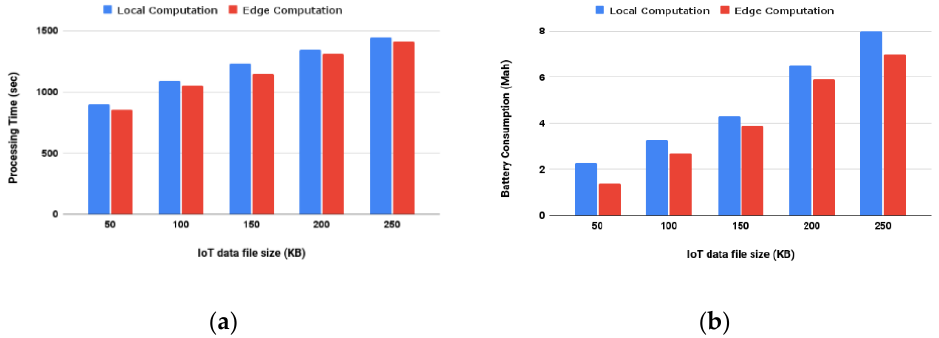
Figure 10. Results of online experiments for local and edge computation ( a ) processing time for given IoT data file size ( b ) battery consumption for given IoT data file size (Figure ( a ) is on the left, Figure ( b ) is on the right ( b )).